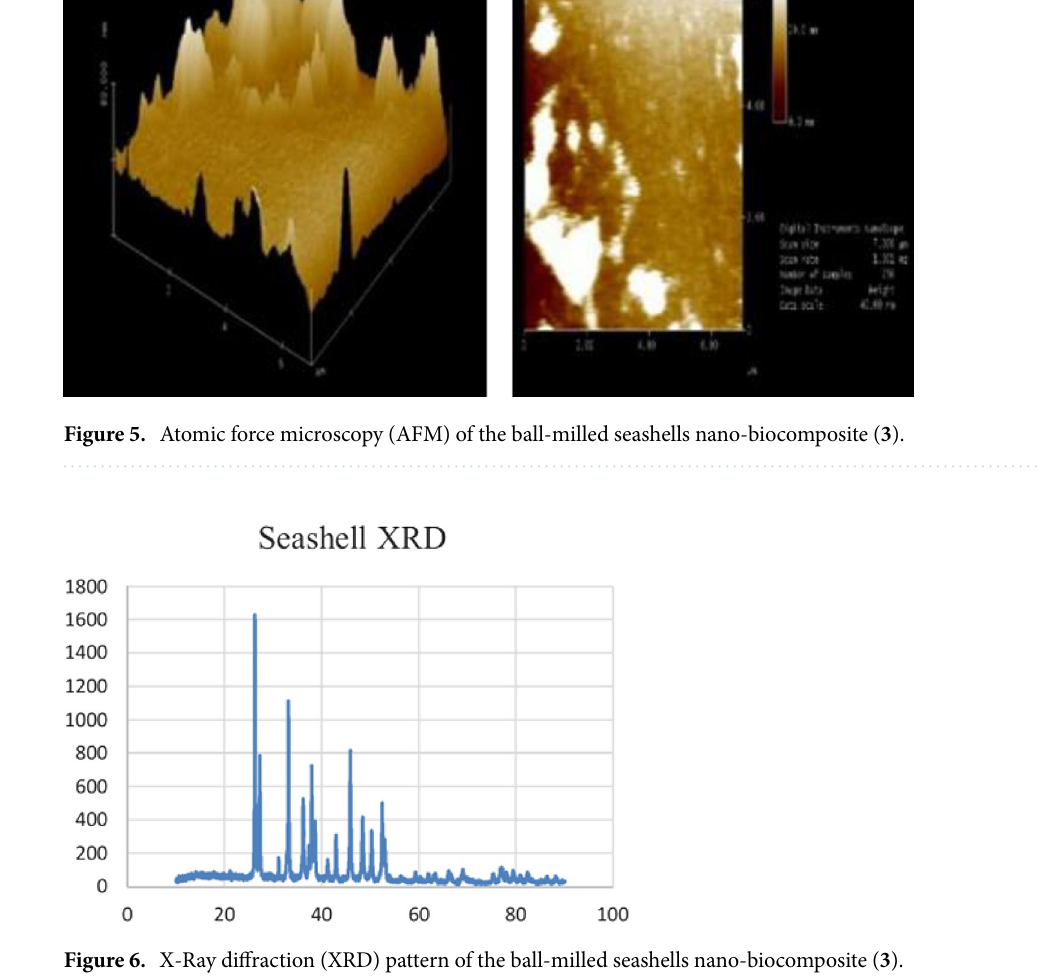
Figure 6. X-Ray diffraction (XRD) pattern of the ball-milled seashells nano-biocomposite ( 3